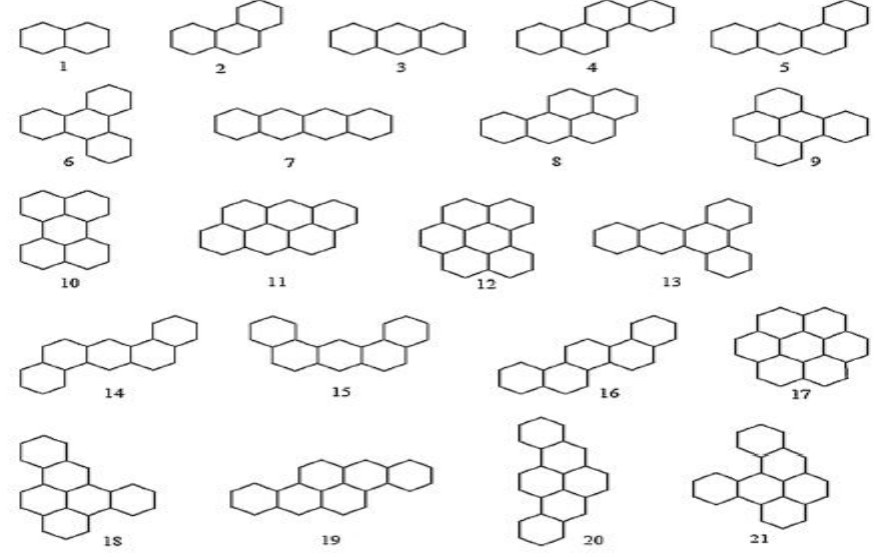
Figure 7. Molecular networks of benzenoid